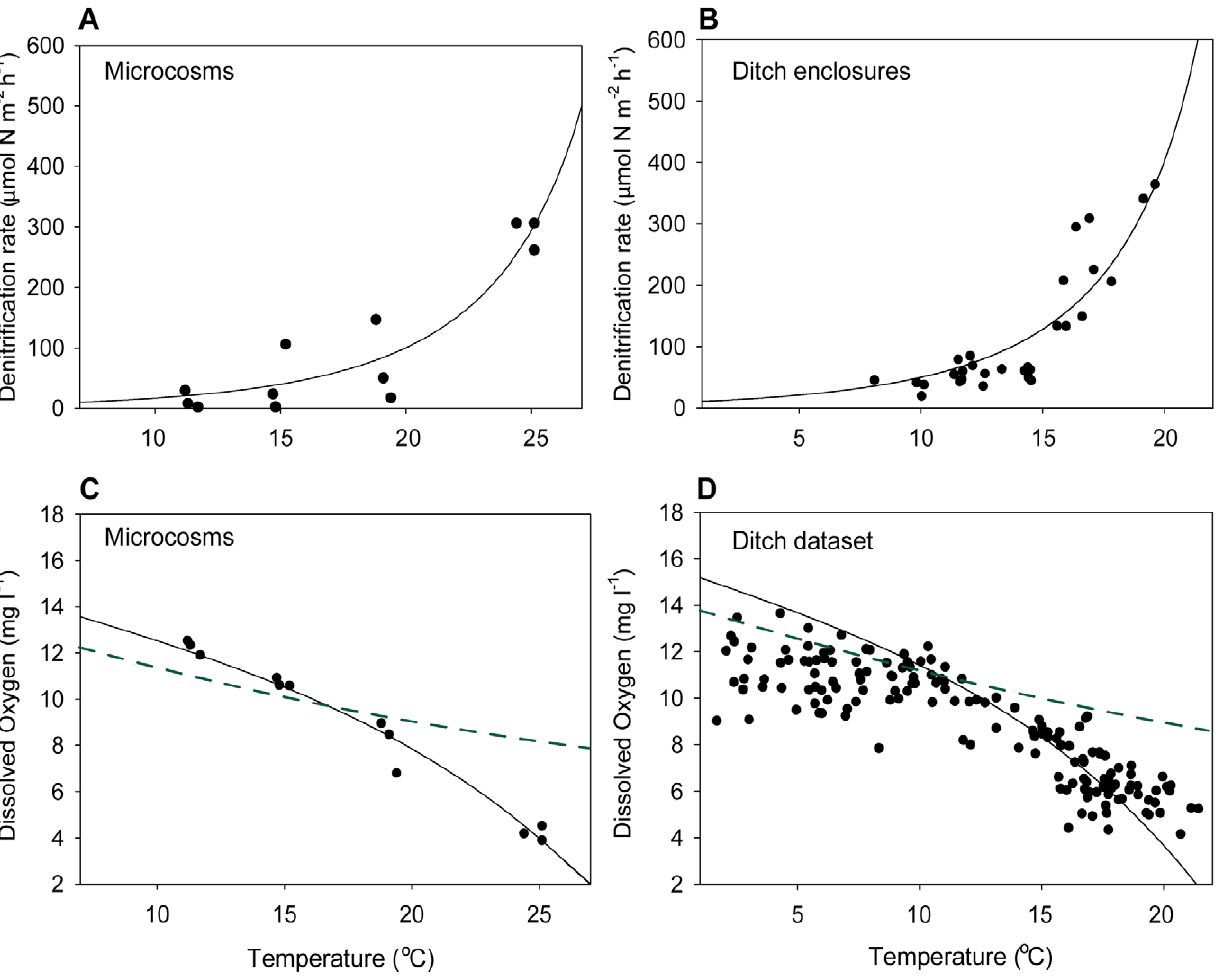
Figure 2. Temperature dependence of denitrification and dissolved oxygen concentrations. Panels show: Denitrification rates at different temperatures in vegetated microcosms (A) and vegetated drainage ditches (B). Dissolved oxygen concentrations at different temperatures in vegetated microcosms (C) and in drainage ditches based on monthly average values (April-July) at 3100 sites for the years 1980–2005 (D). Solid lines show the model predictions based on equation (2) (panels A and B), and equation (3) (panels C and D). Dashed lines represent the temperature dependence of the saturation concentration of oxygen (equation 4).